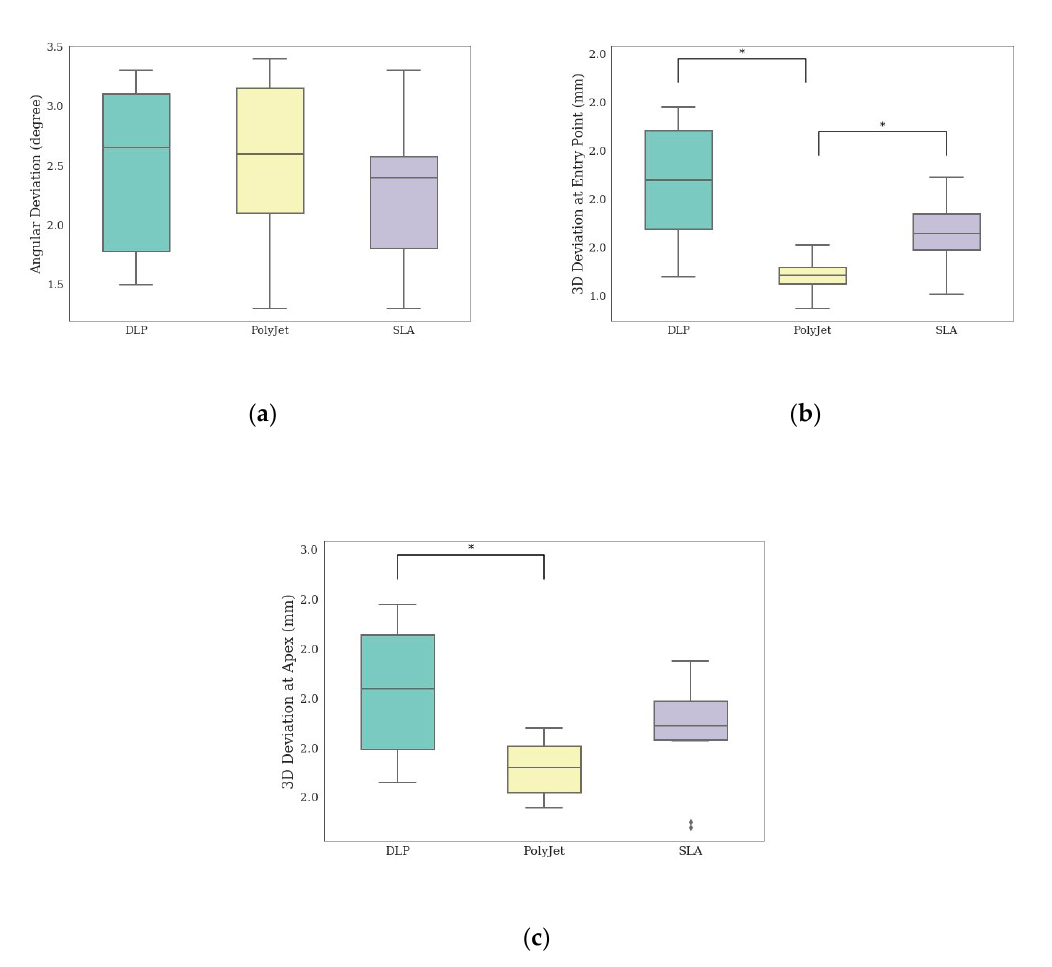
Figure 5. Boxplots of mean 3D deviation: ( a ) Angular deviation; ( b ) 3D deviation at entry point; and ( c ) 3D deviation at apex. The asterisk represents whether the difference of a measurement between any 2 groups is statistically significant ( p < 0.05).